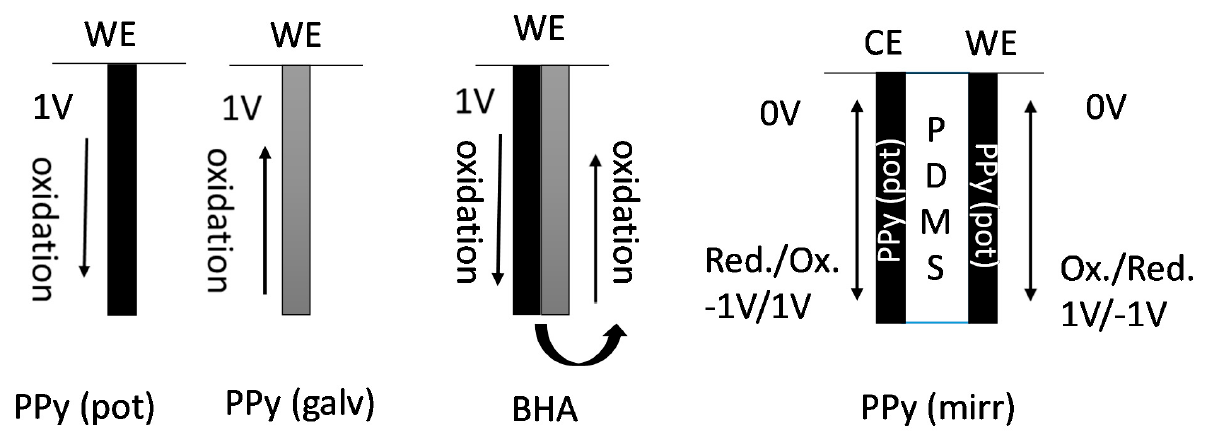
Figure 3. PPy(pot) and PPy(galv) in different arrangements: as freestanding films, BHA (bilayer) and linear trilayer actuator (PPy(mirr)). WE refers to the working electrode, CE to counter electrode. The arrows symbolize expansion or contraction under given conditions.